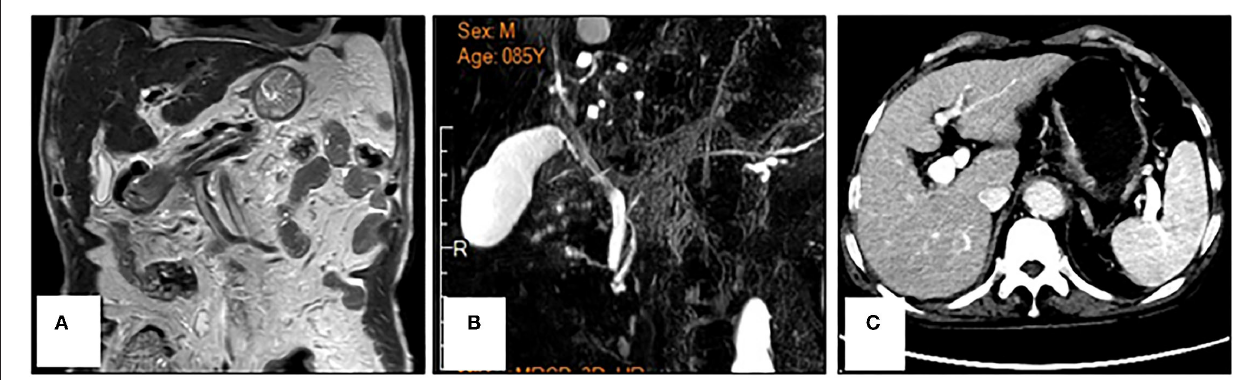
FIGURE 3 | Reprensentative images of magnetic resonance cholangiopancreatography (A,B) and abdominal computed tomography (C) in a patient with metastatic gastric cancer and rare severe immune-related cholestatic hepatitis and subsequent severe late-onset pneumonia after pembrolizumab therapy. No obvious biliary obstruction was